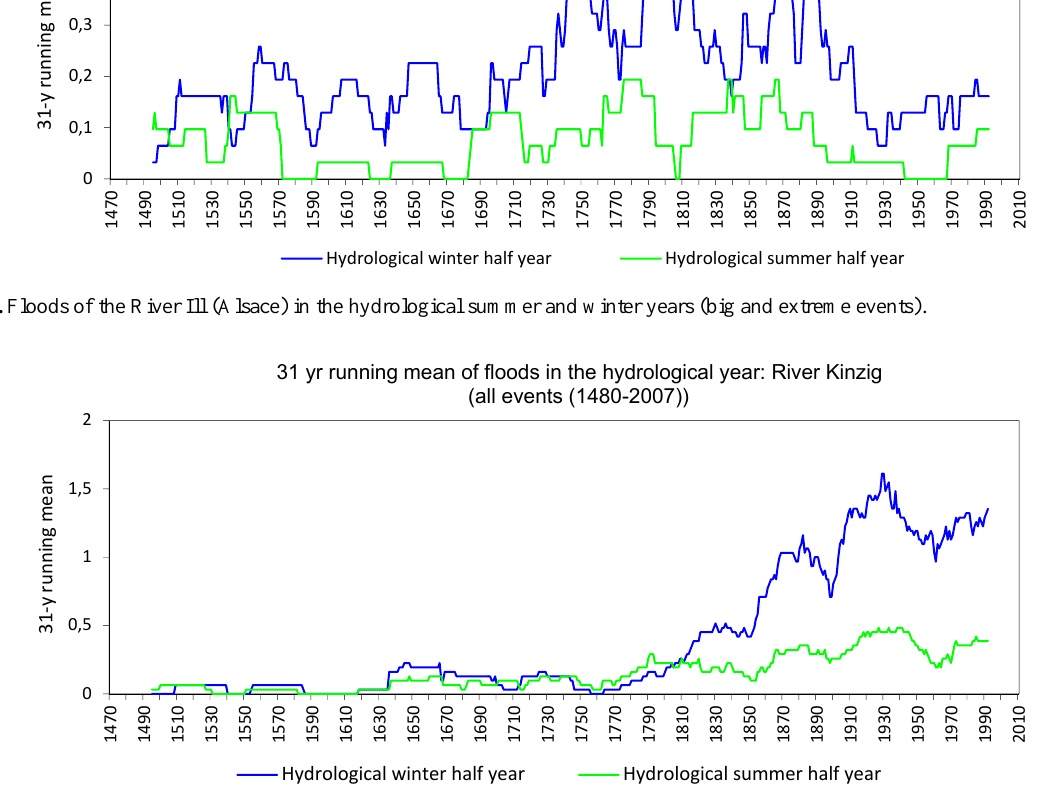
Figure 12. Floods of the River Kinzig (Baden-Württemberg) in the hydrological summer and winter years (all